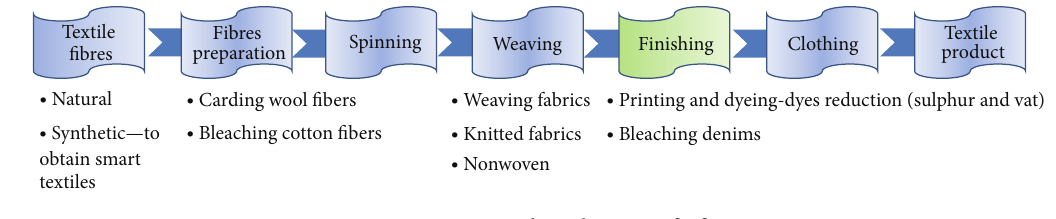
Figure 5: A typical textile process [25].